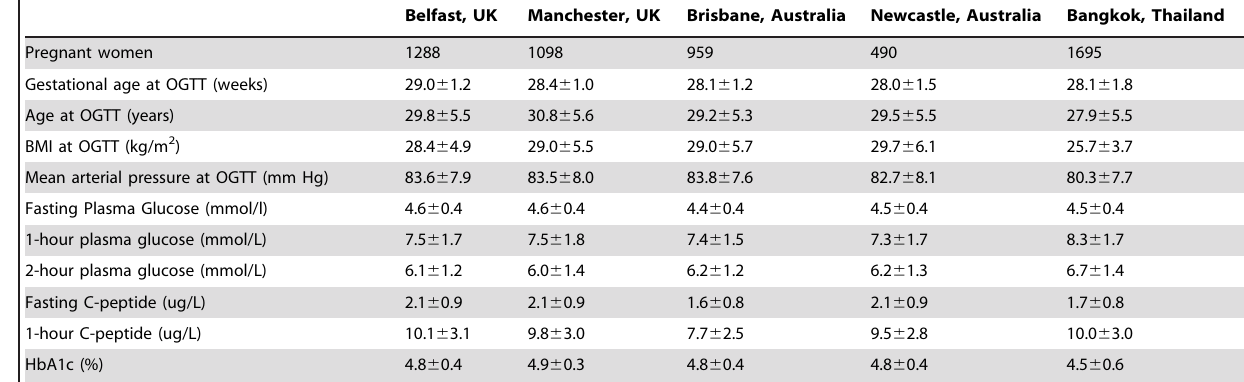
Table 5. Baseline characteristics of study